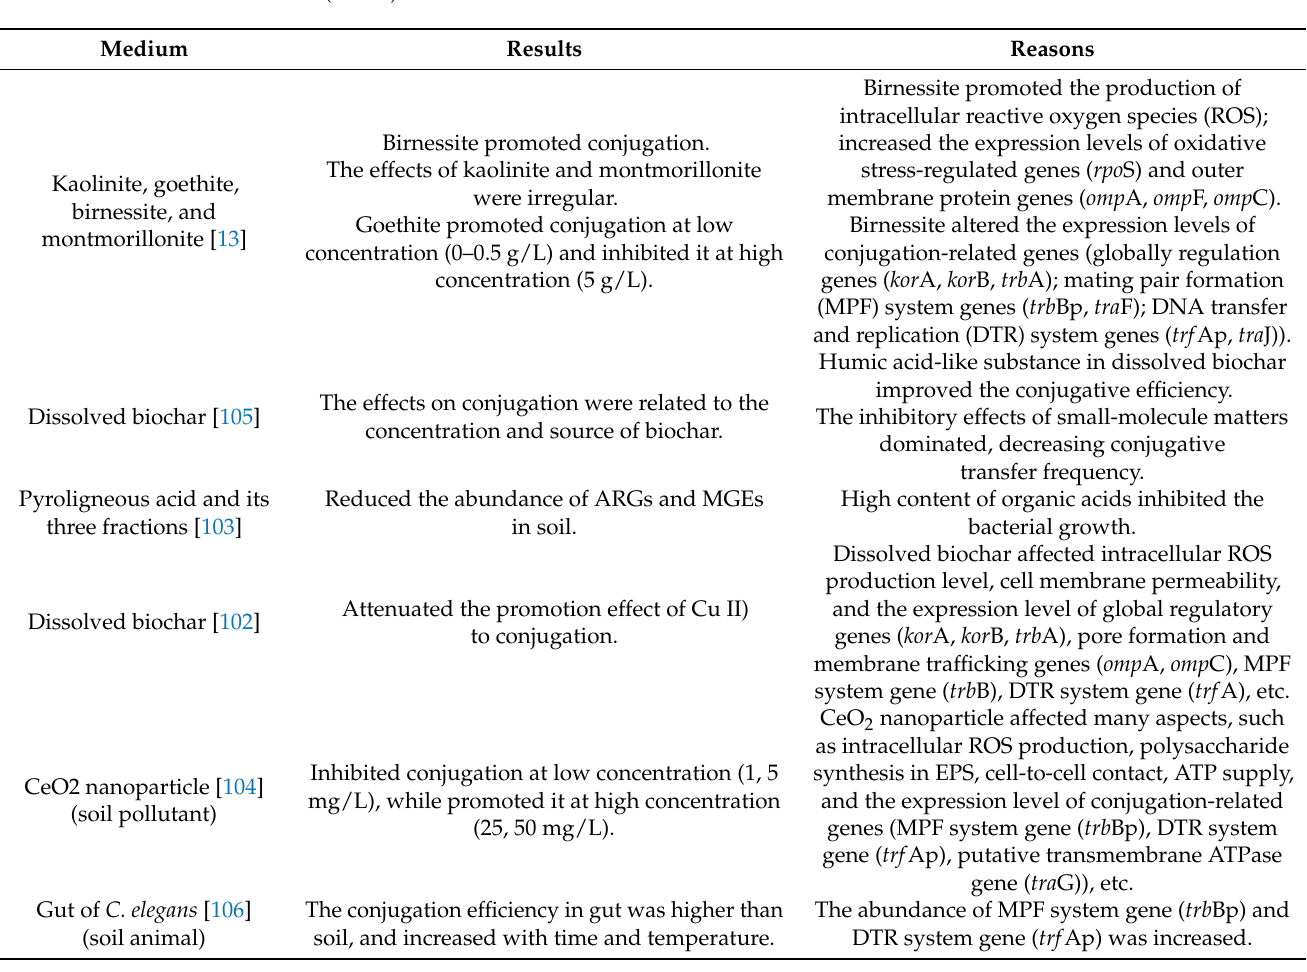
Table 5. Research on the effects of soil components on conjugation of antibiotic resistance genes